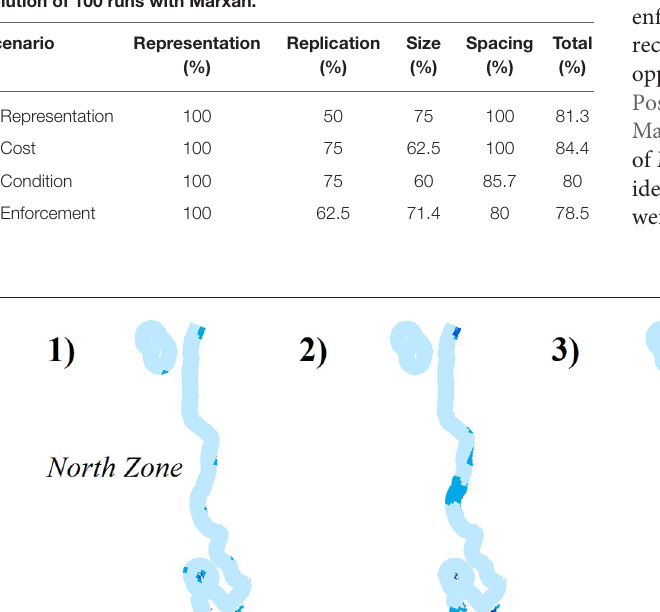
Frontiers in Marine Science |